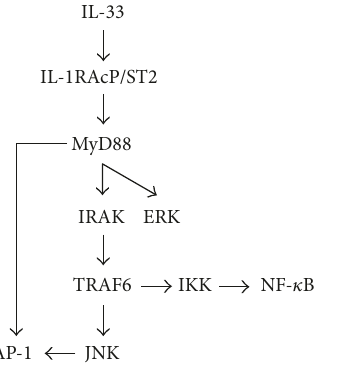
Figure 1: A schematic diagram of an IL-33 signaling